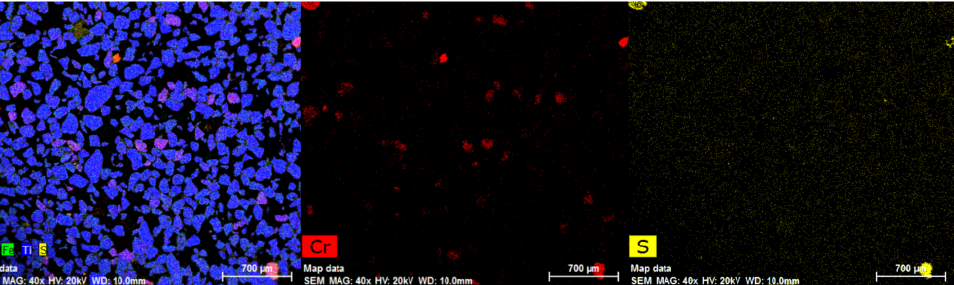
Figure 17. EDX mapping of sample DM‒3 (non-magnetic fraction) after magnetic separation at 0.7 A.